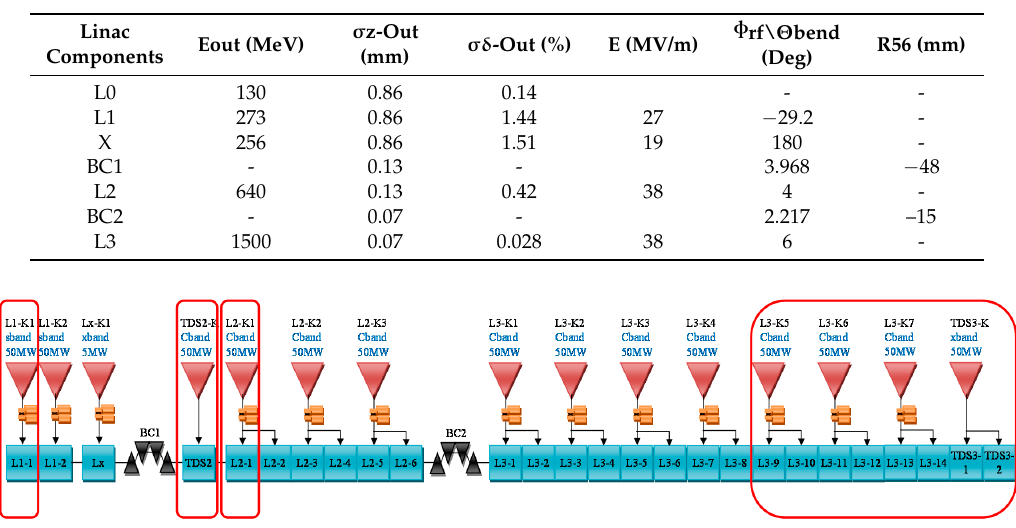
Figure 12. Layout of the main linac of the SXFEL-UF. (Reprint from reference [26])